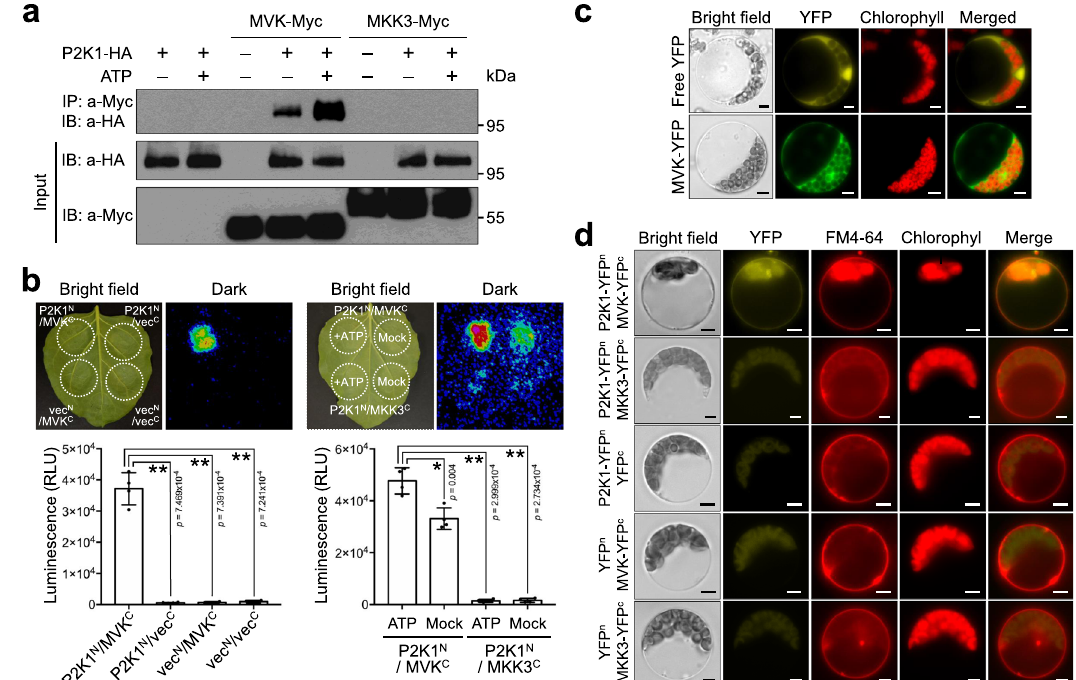
Fig. 5 MVK interacts with P2K1 in vivo. a Co-immunoprecipitation of P2K1 and MVK proteins. The indicated constructs were transiently co-expressed in Nicotiana benthamiana leaves in fi ltrated with either 200 μ M ATP for 30 min ( + ) or 2 mM MES (pH 5.7) as a control ( − ). Full-length MKK3 was used as a negative control. Co-IP was performed using anti-HA and anti-Myc antibodies. b Split-luciferase assay image of N. benthamiana leaves co-in fi ltrated with Agrobacterium strains containing P2K1 N /MVK C , P2K1 N /vec C , vec N /MVK C , vec N /vec C , and P2K1 N /MKK3 C (Negative control). Dotted circles indicate leaf panels that were in fi ltrated with Agrobacterium carrying the respective constructs. + ATP, Leaves in fi ltrated with 200 µ M ATP; Mock, Leaves in fi ltrated with 2 mM MES (pH 5.7). Quanti fi cation of relative luminescence unit (RLU) intensity of P2K1 N /MVK C . Asterisks indicate signi fi cantly different from P2K1 N / vec C , vec N /MVK C , and vec N /vec C (left bottom, n = 4 leaves; ** P < 0.01, two-sided Student ’ s t test) or negative control P2K1 N /MKK3 C (right bottom, n = 4 leaves; * P < 0.01, ** P < 0.001, two-sided Student ’ s t test). c Subcellular localization of MVK in Arabidopsis protoplast. Arabidopsis MVK fused to YFP shows cytosolic localization. Free YFP was used as a control. Scale bars: 5 µ m. d Biomolecular fl uorescence complementation (BiFC) assay in Arabidopsis protoplasts. The indicated constructs were transiently expressed in wild-type protoplasts and the BiFC assay was performed. See also the quanti fi cation of relative fl uorescence intensity shown in Supplementary Fig. 8. FM4-64 was applied to stain the plant plasma membrane. MKK3 was used as a negative control. Scale bars: 5 µ m. All above experiments were performed and analyzed three times with similar